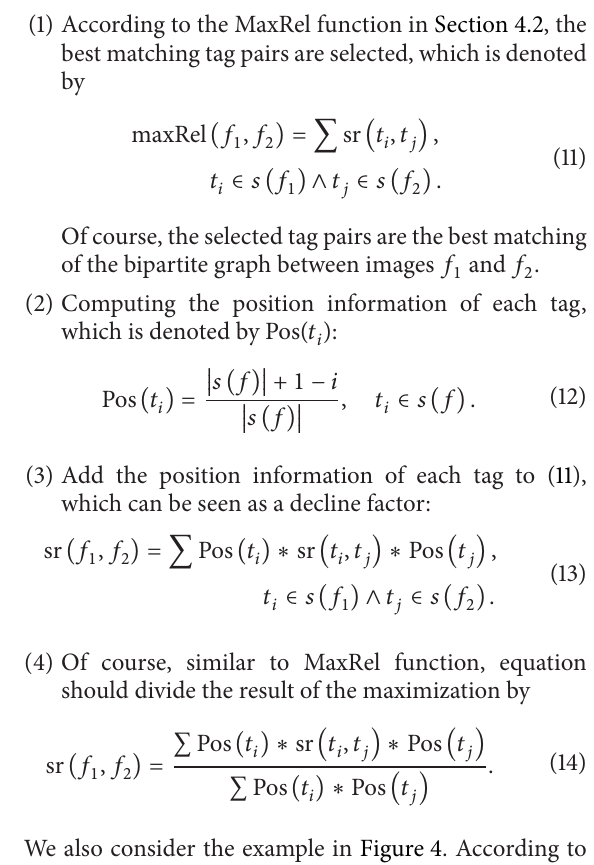
Figure 4: Graphical representation of the assignment in bipartite graphs